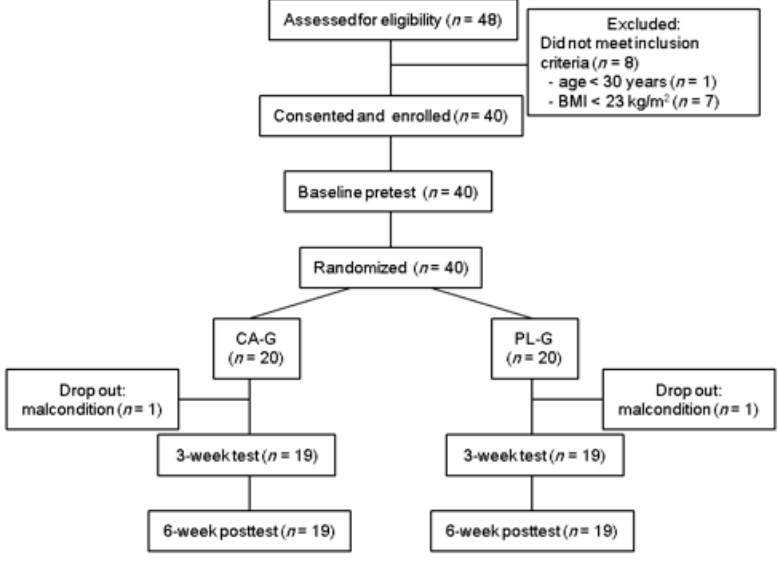
Figure 1. Flowchart for the selection of subjects. CA-G, capsinoid group; PL-G, placebo group. Table 1. Subject profiles and the average room temperature at each measurement point. Capsinoid ( n = 19) Placebo ( n = 19) Baseline